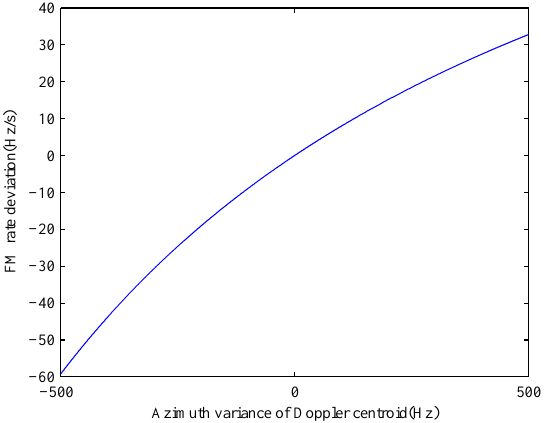
Figure 8. Frequency modulation rate deviation. The azimuth spectrum of the reference target is moved to the center of the azimuth frequency, and the x coordinate represents the difference of Doppler centroid between an arbitrary target and the reference